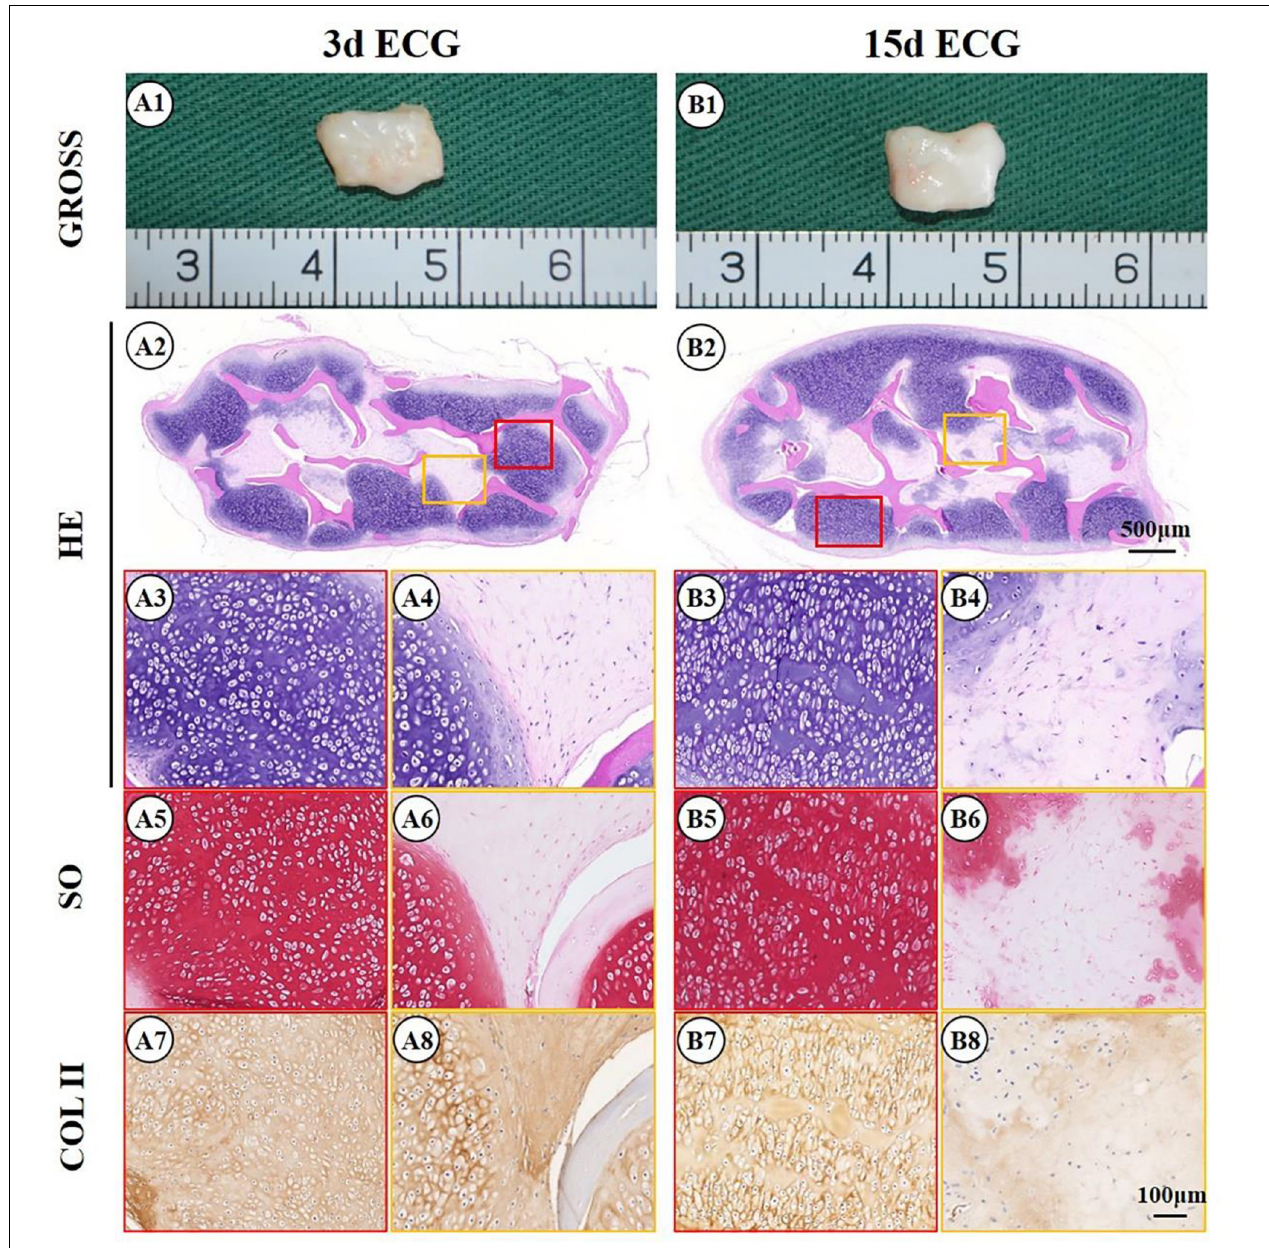
FIGURE 3 | Gross view and histological examination of the cartilage regenerated by goat engineered cartilage gel (ECG) after 12 weeks in vivo in nude mice. Gross view, HE, Safranin-O, and collagen II immunohistochemical staining of 3 d ECG–decalcified bone matrix (DBM) (A1–A8) and 15 d ECG–DBM constructs (B1–B8) . The red box represents the mature cartilage-like tissue areas, and the orange box represents the immature cartilage-like